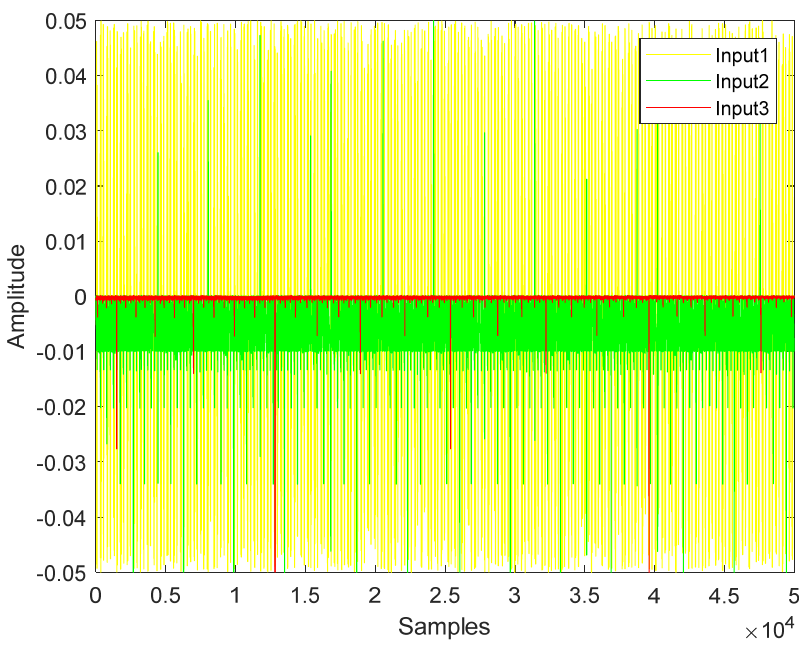
Figure 2. The error time series of different input signals under healthy status.